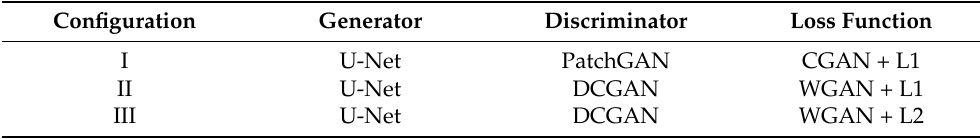
Table 3. Configurations of GANs for 3D reconstruction.